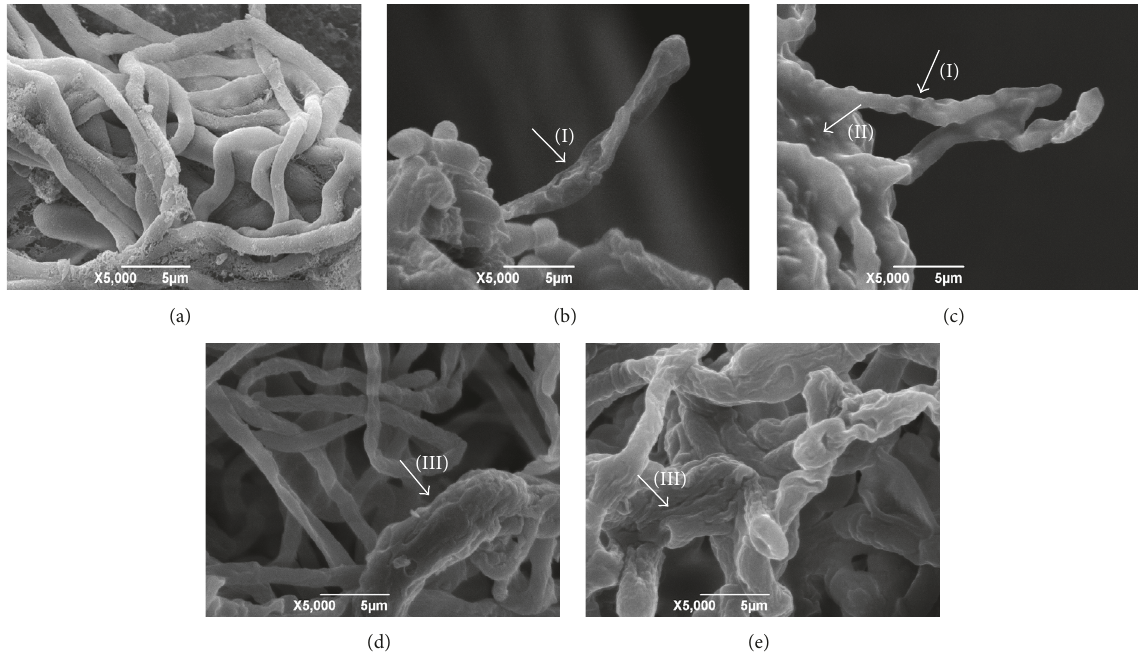
Figure 3: Electron micrographs of M. gypseum ATCC 14683 exposed or not to the reference drugs and hexahydropyrimidine derivative of interest. (a) M. gypseum ATCC 14683 not subjected to pharmacological treatment; (b) M. gypseum ATCC 14683 subjected to treatment with terbinafine; (c) M. gypseum ATCC 14683 subjected to treatment with ketoconazole; (d) M. gypseum ATCC 14683 subjected to treatment with HHP3; (e) M. gypseum ATCC 14683 subjected to treatment with HHP4. Arrows indicate the appearance of wrinkled (I) and crushed (II) hyphae and wrinkled macroconidium (III).